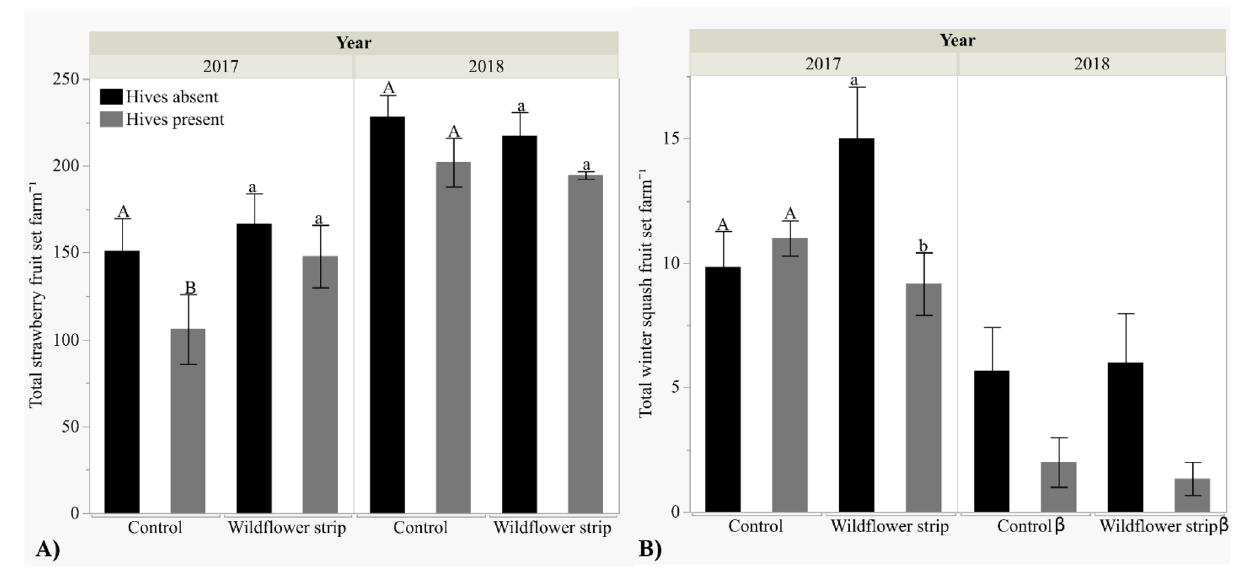
Figure 4. Mean total fruit count (± SE) per farm by wildflower strip and honey bee hive presence/absence on farms. Hive treatment means are compared within each wildflower strip treatment: the same letter indicates means are not statistically significant (α = 0.05), and β indicates sample sizes are insufficient for means comparisons. (See Supplemental Table S4 for sample size details.) ( A ) Strawberries, ( B ) Winter